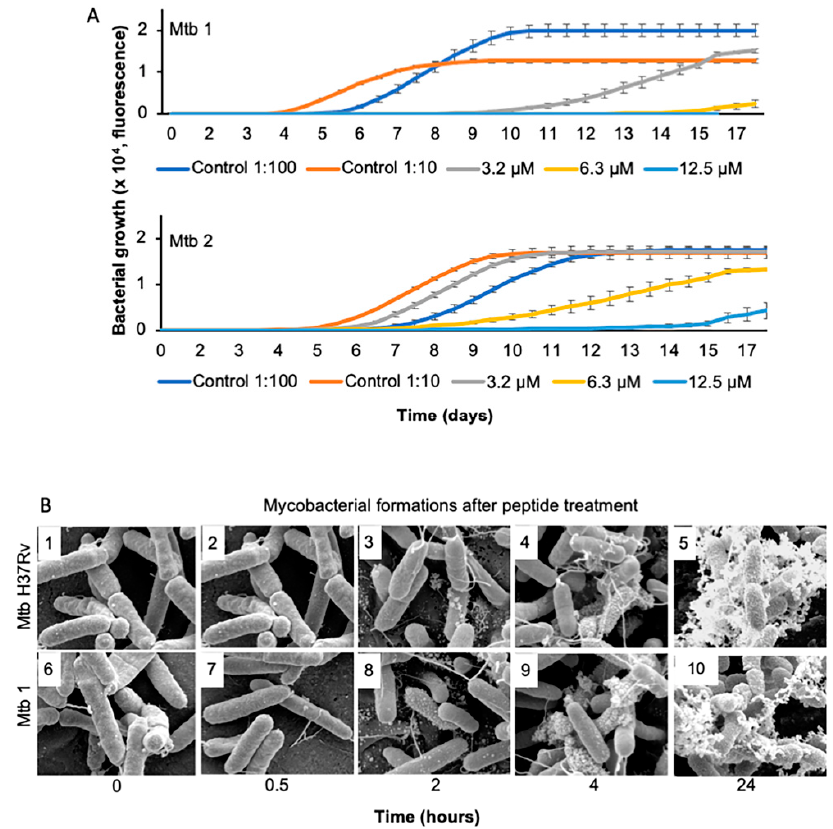
Figure 1. Kinetics of cell proliferation and death in clinical M. tuberculosis strains upon exposure to NZX. ( A ) Graphs depicting the growth kinetics of M. tuberculosis using the MGIT960 culture system for a period of 18 days. The M. tuberculosis isolates Mtb 1 and Mtb 2 were treated once with 3.2, 6.3 or 12.5 µ M NZX at day 0, and their growth was measured for 18 days. Data depict an average of three replicates. ( B ) M. tuberculosis H37Rv and the clinical M. tuberculosis isolate Mtb 1 were treated with 6.3 µ M of NZX for up to 24 h and visualized with scanning electron microscopy (SEM). Different kinds of destabilization of the membrane were observed, from intact forms to bubbling formations. Scale bar: 2 μ m. Experiments were repeated three times for each strain.